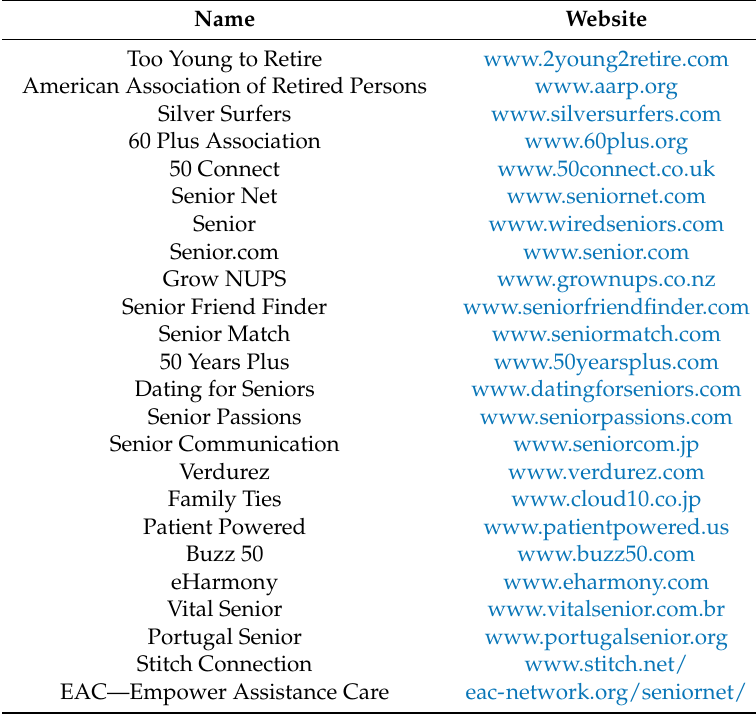
Table 2. Some Social Networks for